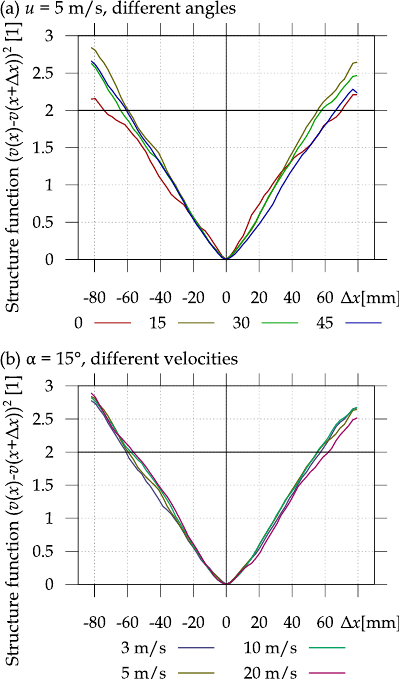
Fig. 7. Top : structure function S 2 of the span-wise velocity as a vv function of ∆ x , stream-wise velocity u = 5m / s, di ff erent colors represent di ff erent angles of attack. Bottom : structure function S 2 for di ff erent velocities at constant angle of attack α = 15 ◦ . vv